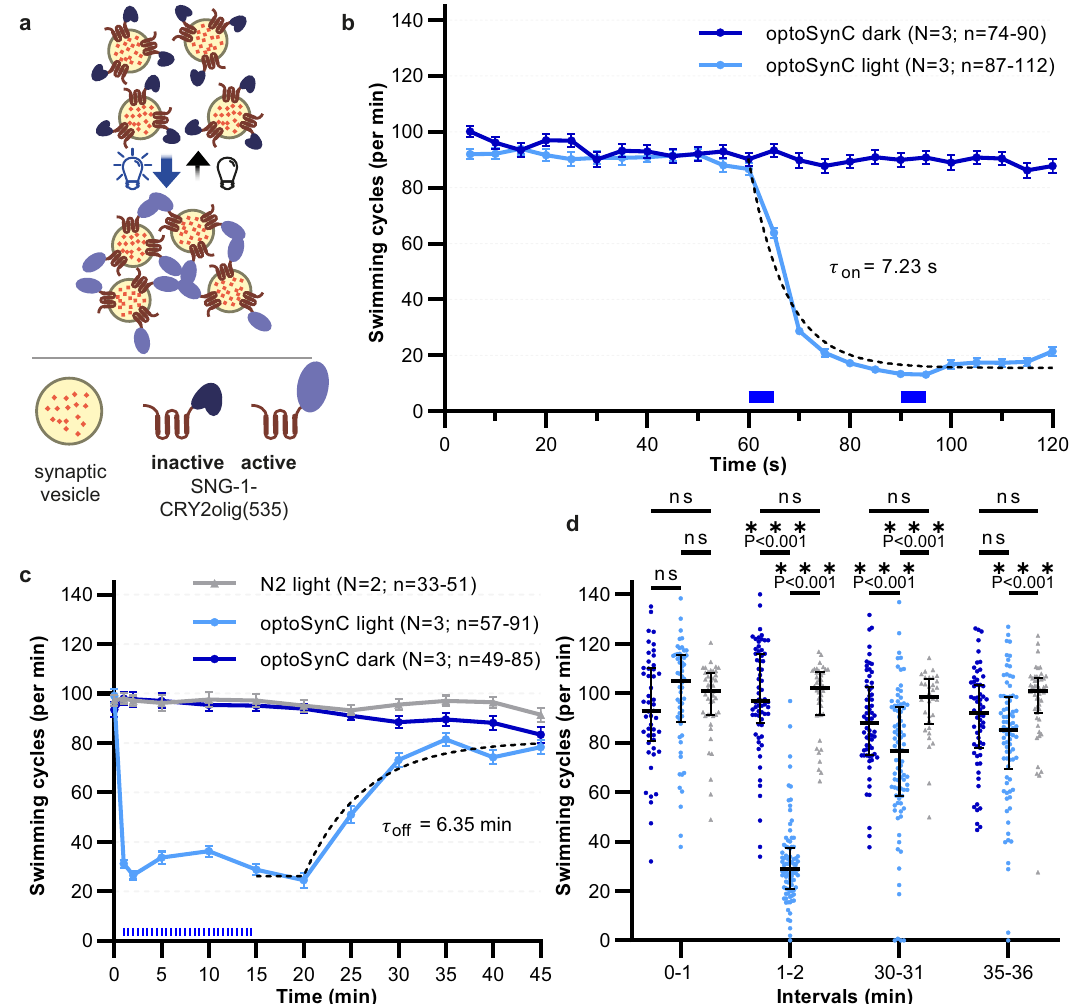
Fig.1|OptoSynCinhibitsbehaviorwithinsecondsandrecoverswithinminutes inthedark.a SchematicillustratingSVclusteringthroughhomo-oligomerizationof CRY2olig(535) upon blue light illumination. b Mean (±s.e.m.) swimming cycles of wormsexpressingoptoSynCpan-neuronally.Illumination(470nm,0.1mW/mm²,5s /25sISI)isindicatedbybluerectangles;dottedline:one-phasedecay fi t(60 – 120s). c As in b , longer time course. Sustained inhibition of swimming by ongoing light pulses, and recovery in the dark. Dotted line: ‘ plateau followed by one phase asso- ciation ’ - fi t.N2 – non-transgenicwildtype. d